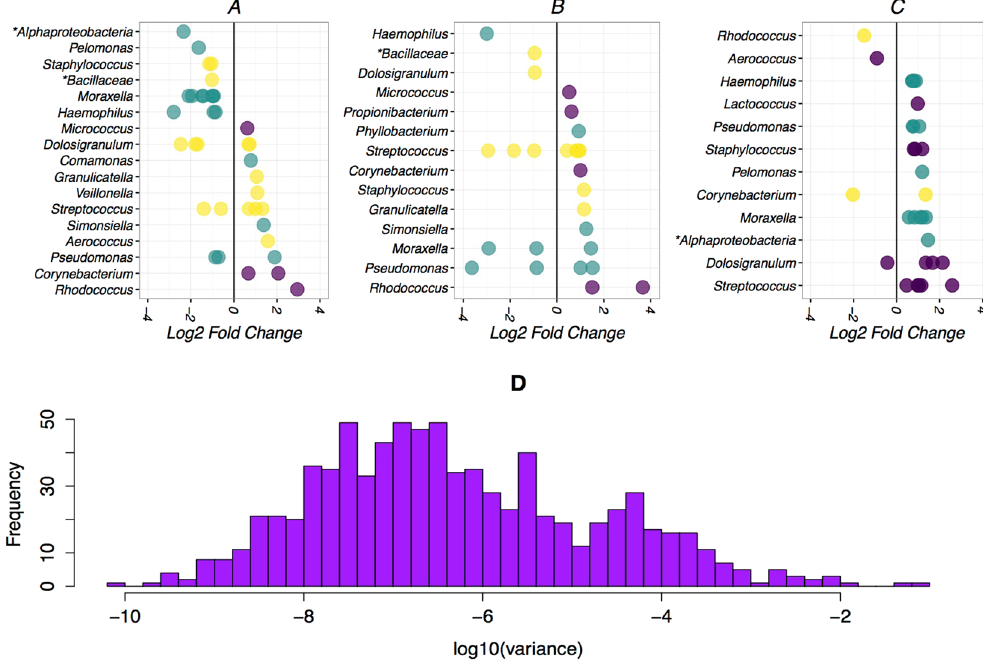
Figure 6. Differentially abundant OTUs across vaccination group in the first year of life. Differential abundance of individual OTUs across the vaccination groups was evaluated by the use of the negative binomial distribution and shrinkage estimator for the distribution’s variance using the DESeq. 2 extension in the Phyloseq package in R. OTUs that were differentially abundant (alpha < 0.01) between Group 1 and 2 ( A ), Group 1 and 3 ( B ), and Group 2 and 3 ( C ). The log10 variance of most OTUs across the samples was very low ( D ). The colours represent the phylum to which the OTUs belong: purple circles represent Firmicutes , green circles represent Proteobacteria and yellow circles represent Actinobacteria . The asterisk ( * ) indicates a taxanomic Class while the other labels represent